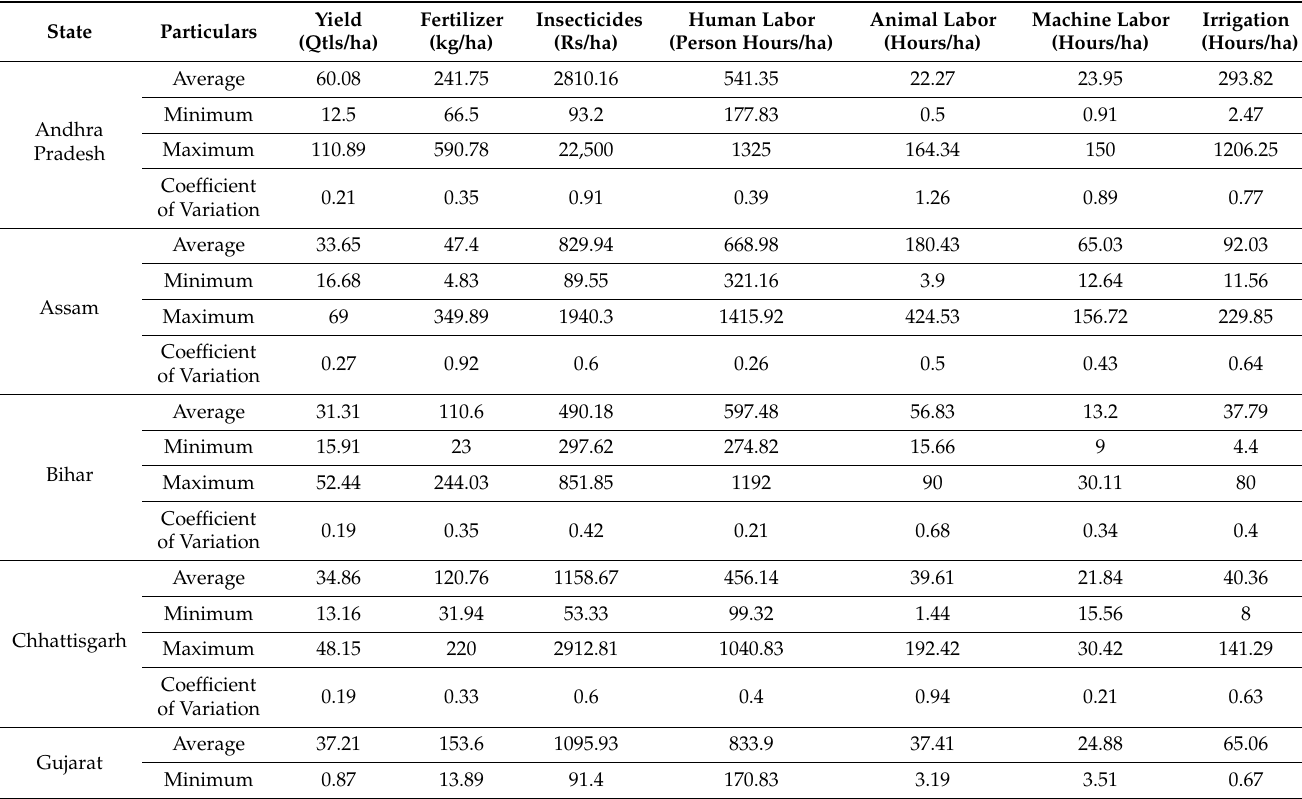
Table 6. Descriptive statistics of the parameters used in the stochastic frontier model estimated from cross-sectional farm level data for